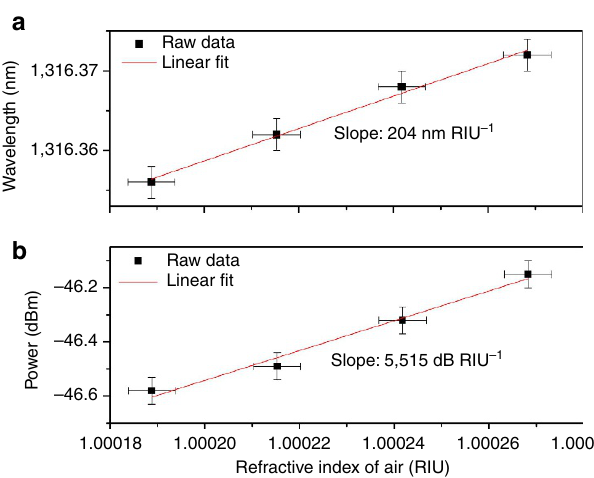
Figure 6 | Sensor response to a change of the refractive index of air. Evolution of the wavelength ( a ) and minimum power level ( b ) of the most sensitive cladding mode resonance as a function of the SRI variation due to atmospheric pressure changes. Error bars result from the uncertainties in the determination of the cladding mode resonance ( ± 2pm), power level ( ± 0.05dBm) and atmospheric pressure ( ±